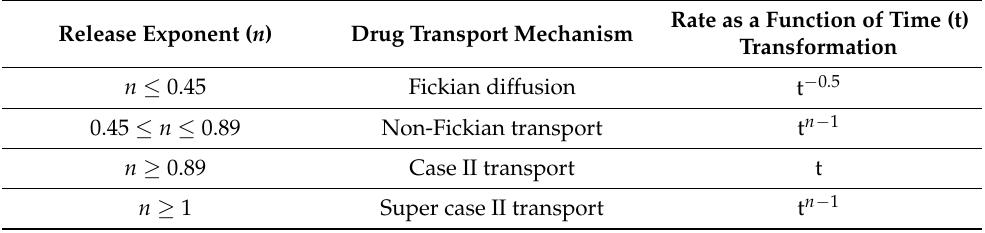
Table 6. Variability of release exponent ( n ) and the respective release